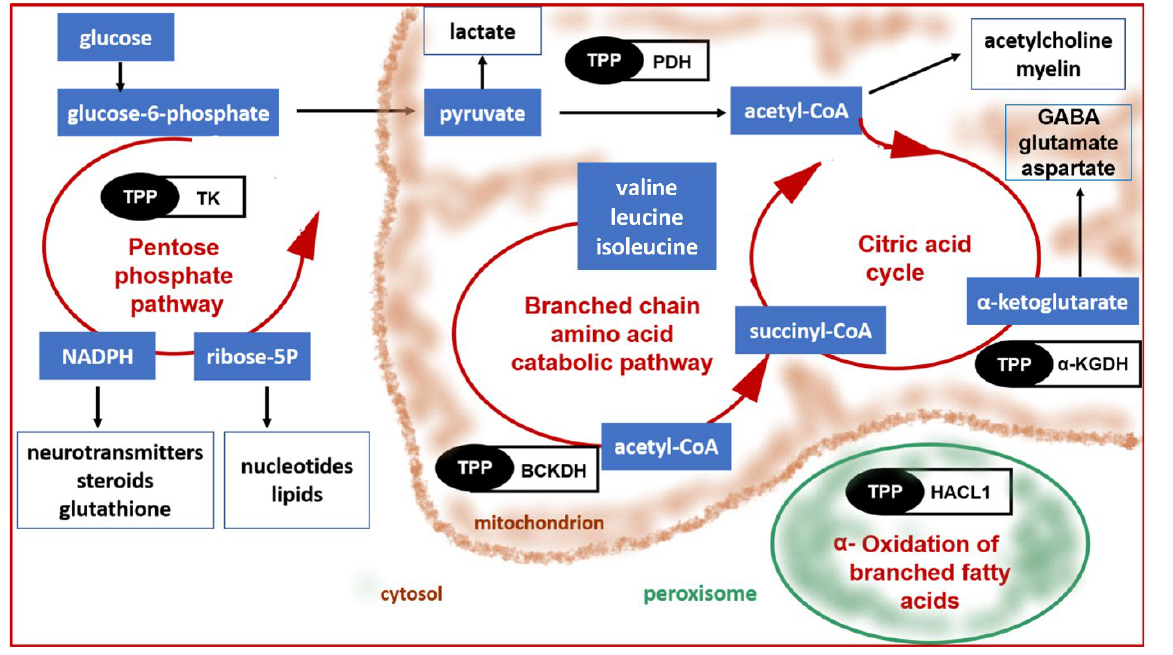
Figure 4. Cellular pathways requiring thiamine pyrophosphate (TPP) as a cofactor. BCKDH, branched- chain α -ketoacid dehydrogenase; PDH, pyruvate dehydrogenase; α -KGDH, α -ketoglutarate dehydrogenase; TK, transketolase; HACL1, 2-hydroxyacyl-CoA lyase 1.